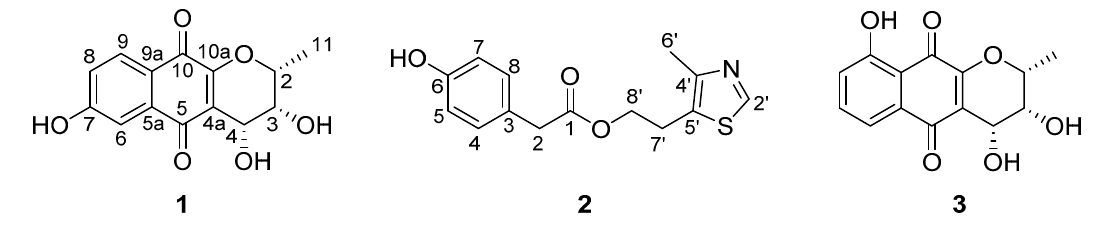
Figure 1. Chemical structures of compounds 1 – 3 .